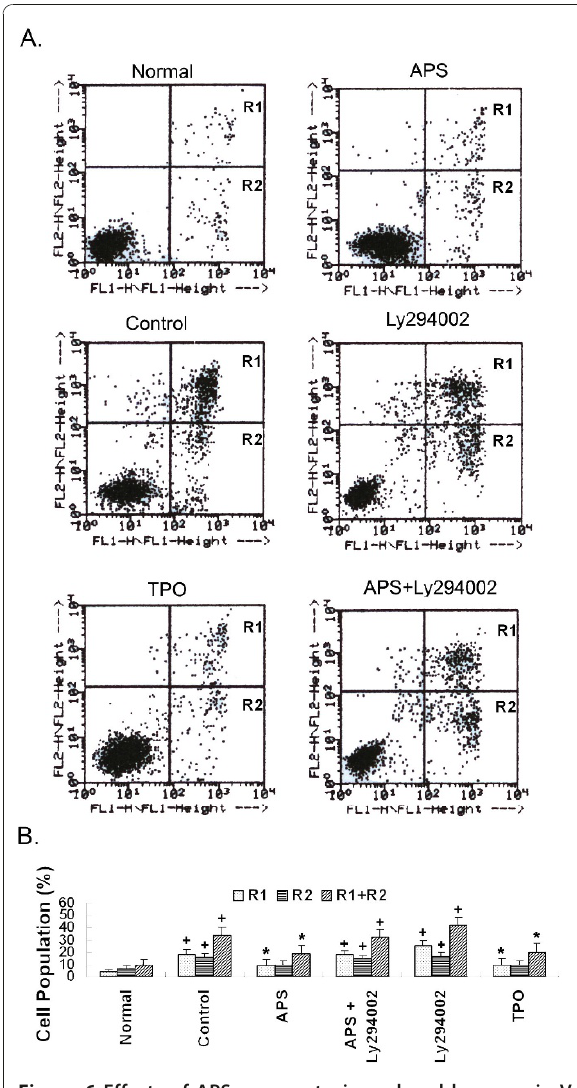
Figure 6 Effects of APS on apoptosis analyzed by annexin V assay . Apoptosis was induced by serum depletion (control). APS, TPO or Ly294002 were used to treat the cells for 72 hours. The cells were stained with annexin V-FITC and Propidium Iodide (PI) and subjected to flow cytometry analyses. (A). Dot plots of Normal, APS- treated, Control, Ly294002-treated, TPO-treated, and APS+Ly294002- treated samples. (B). Quantification and statistical analyses of treatment effects. Percentages of R1 (FITC+, PI+, late apoptotic cells), R2 (FITC+, PI-, early apoptotic cells) and R1+R2 (FITC+, total apoptotic cells) are shown. Statistical tests were carried out between the control/treated samples and the corresponding normal samples respectively. *: p < 0.05; #: p < 0.01 and +: p < 0.001.